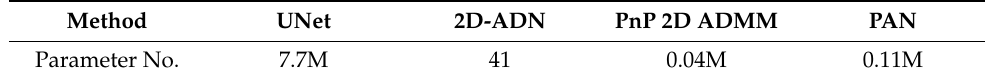
Table 4. Parameters of different methods.